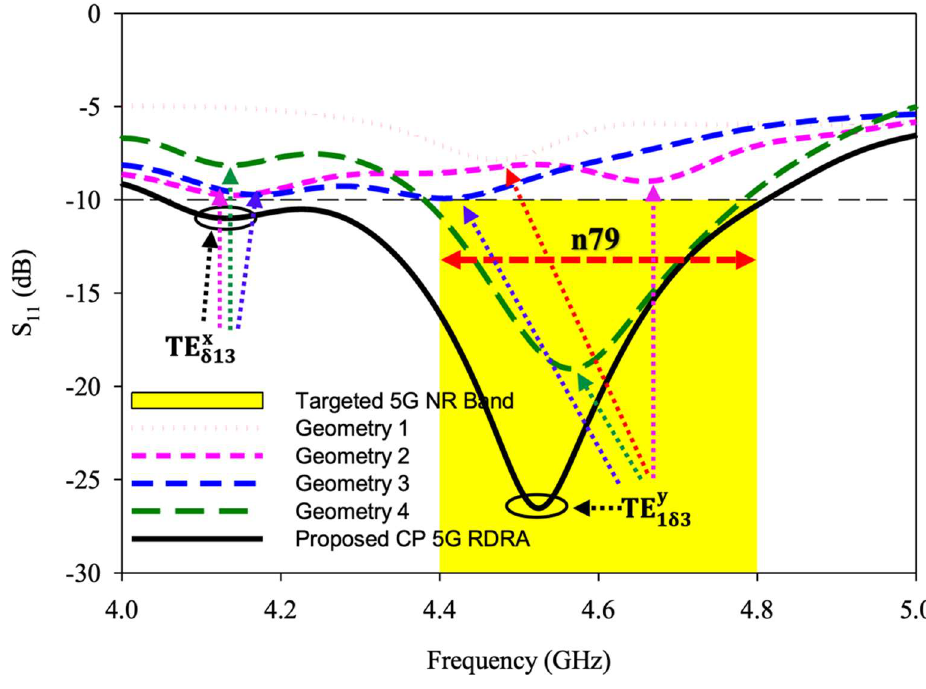
Figure 3. Return losses comparison of different geometries toward the development of the CP 5G RDRA.